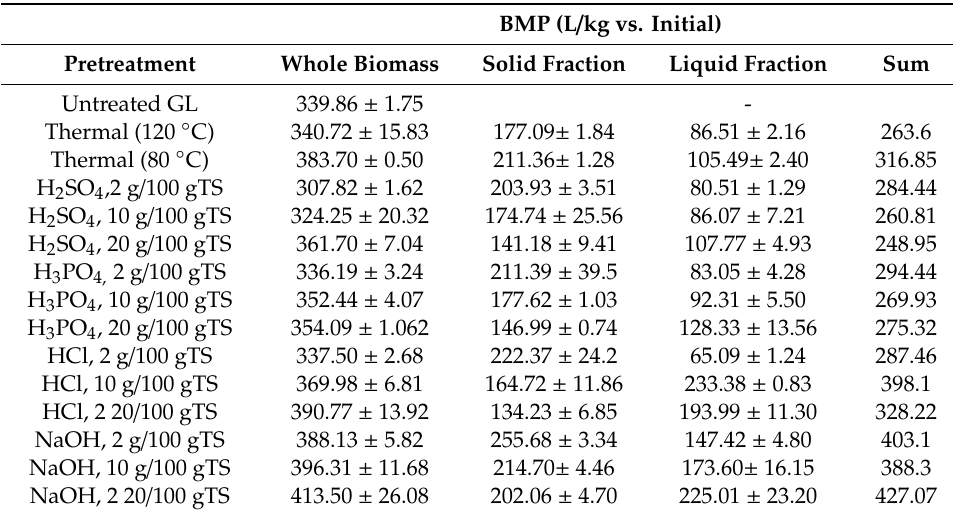
Table 2. BMP of the whole pretreatment slurry and of the separated fractions obtained after all pretreatment